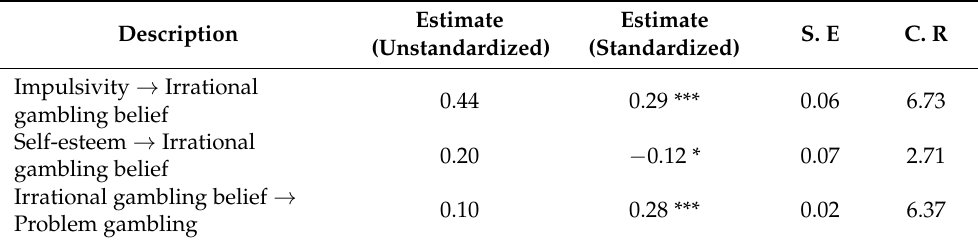
Table 5. Regression weights of the final